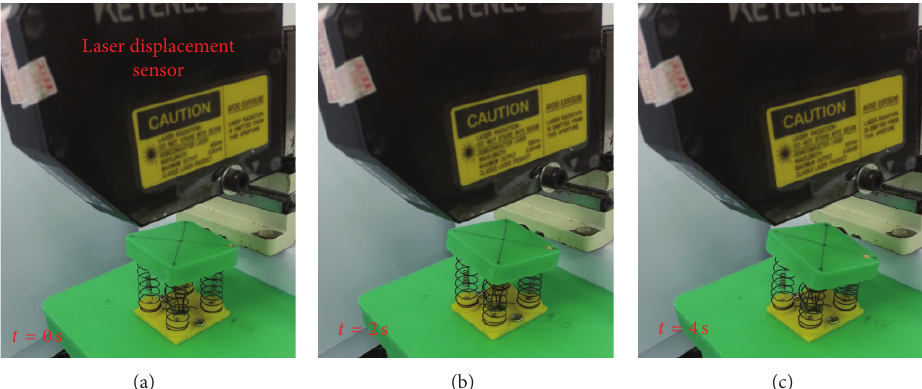
Figure 8: Measurement process of temporal response for miniature Stewart platform prototype at PWM duty cycle of 75%.